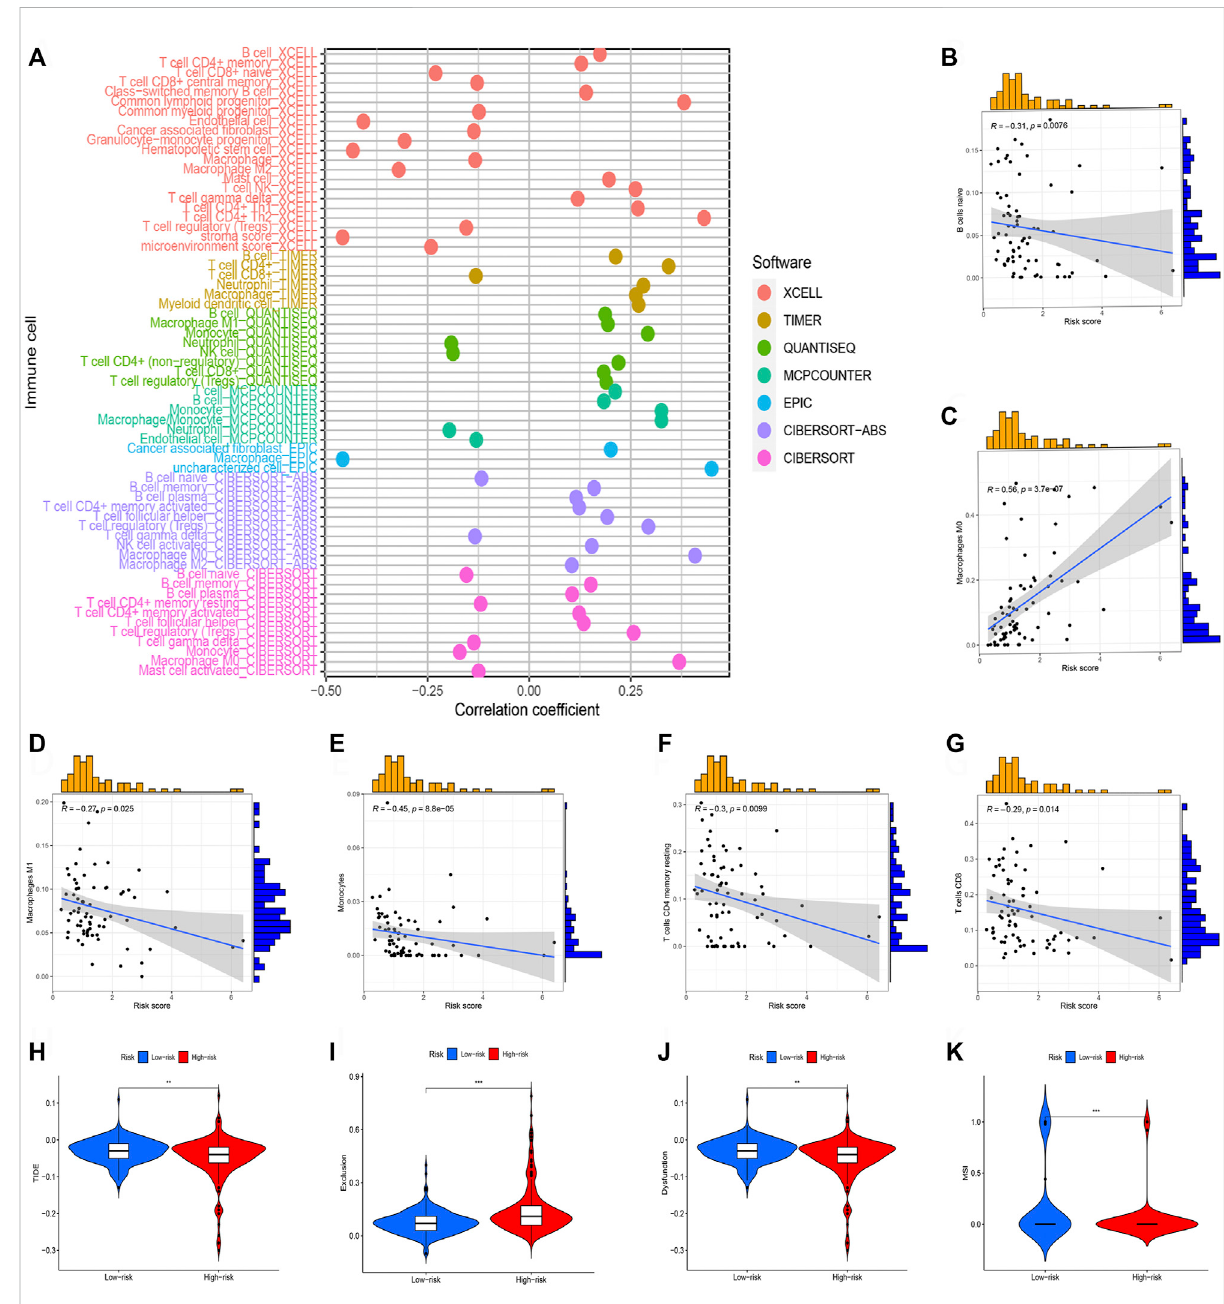
FIGURE 8 Immune cell in fi ltration analysis of different risk groups. (* p < 0.05; ** p < 0.01; *** p < 0.001). (A) Correlation between risk scores and immune cells. (B) The correlation between risk score Naive B cells. (C) The correlation between risk score M0 macrophages. (D) The correlation between risk score M1 macrophages. (E) The correlation between risk score Monocytes. (F) The correlation between risk score resting memory CD4 T-cells. (G) The correlation between risk score CD8 T-cells. (H) TIDE score in different risk groups. (I) Exclusion score in different risk groups. (J) Dysfunction score in different risk groups. (K) MSI score between different risk